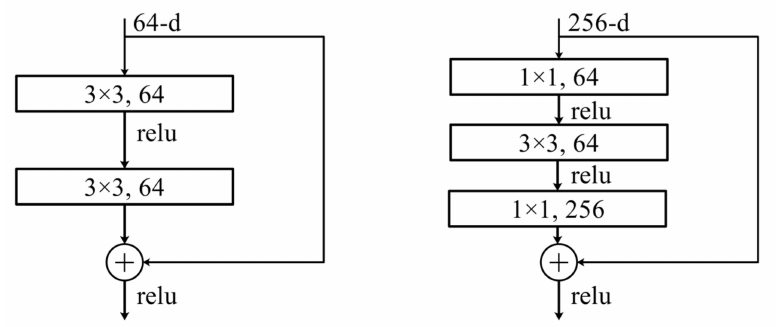
Figure 2. Residual structures of the ResNet. The left panel is for the networks with fewer layers, such as ResNet-18 and ResNet-34. The right one is for the networks with more layers, such as ResNet-101 and